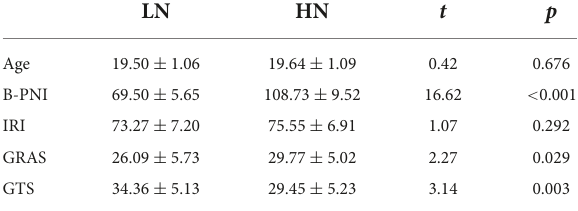
TABLE 1 Sample characteristics ( M ± SD